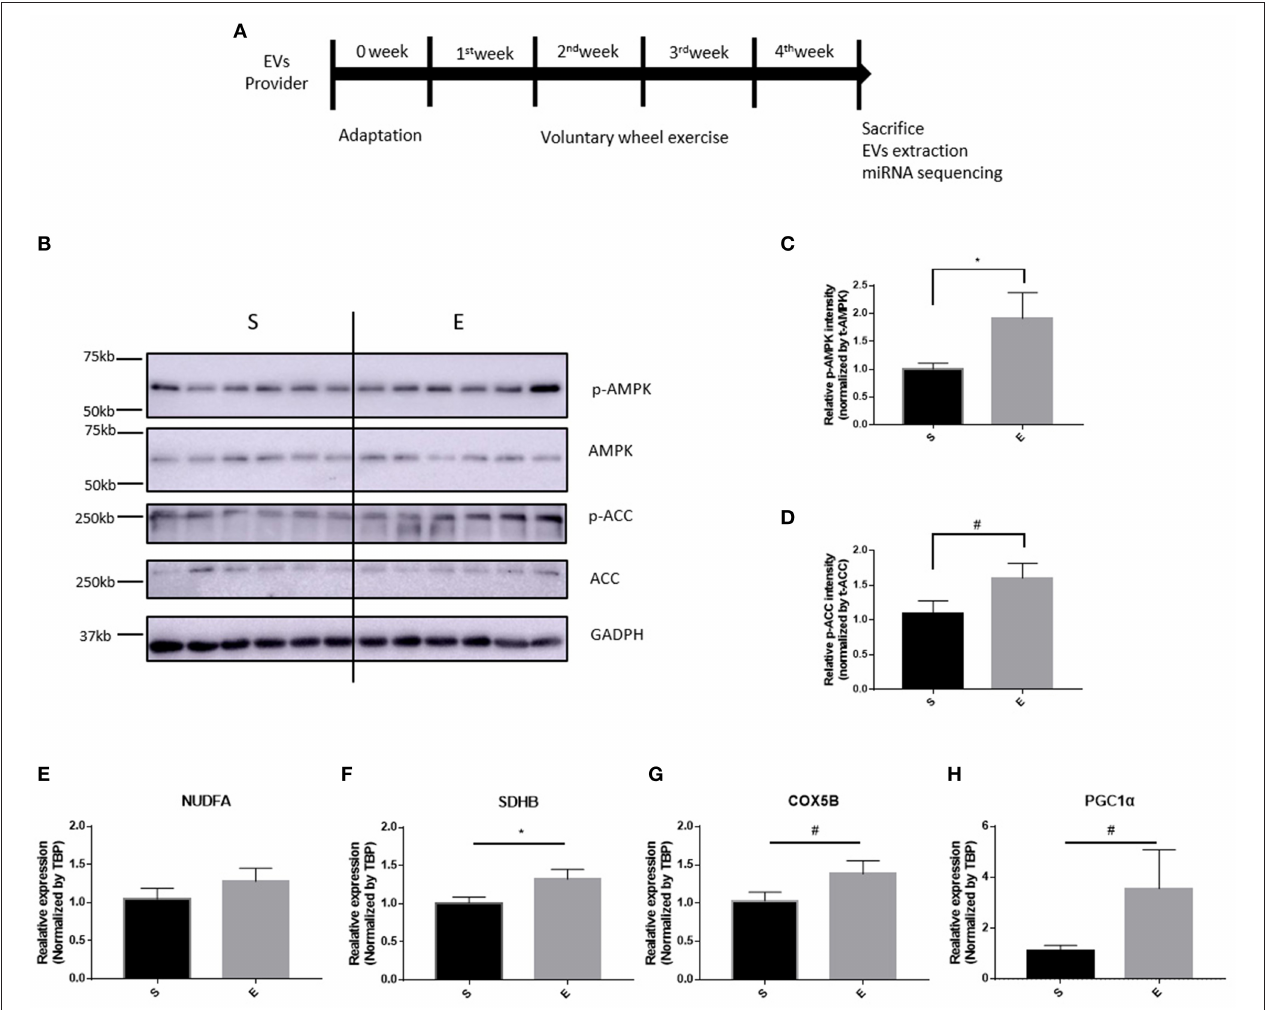
FIGURE 1 | The effects of 4 weeks of voluntary wheel exercise on skeletal muscle proteins and their encoding mRNA levels. (A) The experimental schedule. (B–D) p-AMPK/AMPK and p-ACC/ACC protein levels. (E–H) OXPHOS and Pgc1 α mRNA expression levels in the gastrocnemius. * p < 0.05 vs. S. Statistical analysis was performed with the aid of the one-tailed Student t -test. EVs, Extracellular vesicles; S, sedentary group ( n = 6); E, exercise group ( n = 6). The data represent means ± SEM (* p < 0.05). # p < 0.05.